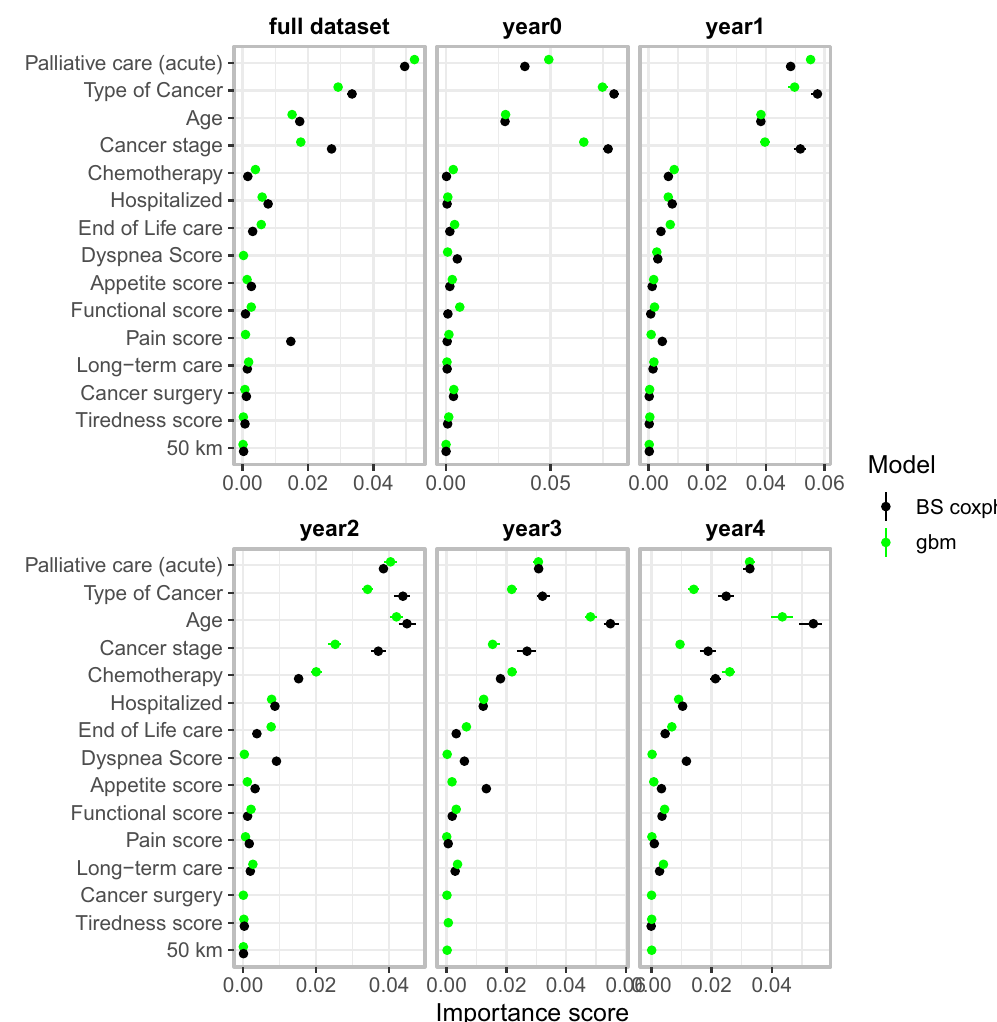
Figure 3. Variable importance scores together with the corresponding 2.5%, 50% and 97.5% quantiles, based on the best (gbm) and benchmark models (BS coxph). Notably, palliative care, age of the patient, cancer type and cancer stage stood out, across the cohorts, as some of the most important prognostic factors on survival of cancer